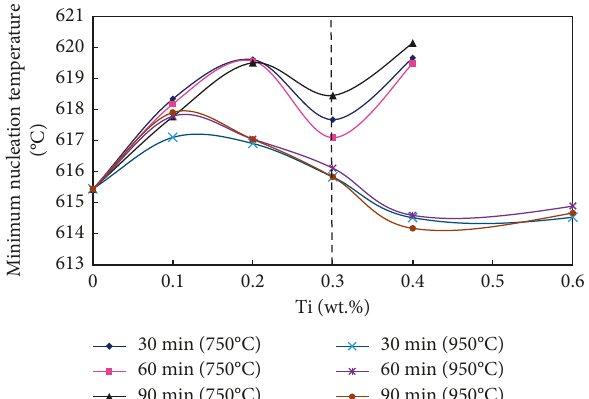
Figure 3: Variation of the nucleation temperature as a function of added Ti and melting conditions. Points above 0.6wt.% Ti are